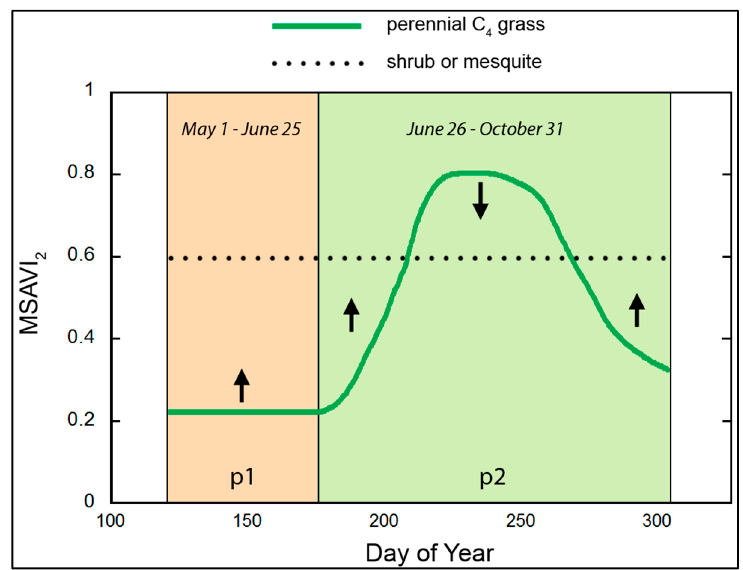
Figure 4. An idealized plot showing seasonal patterns of the spectral modified soil-adjusted vegetation index (MSAVI 2 ) for perennial C 4 grass, and shrub or mesquite, with dense and homogeneous surface cover. The arrows indicate the directions in which the curve for perennial C 4 grass is expected to shift as its surface cover within a pixel becomes replaced by shrub or mesquite.